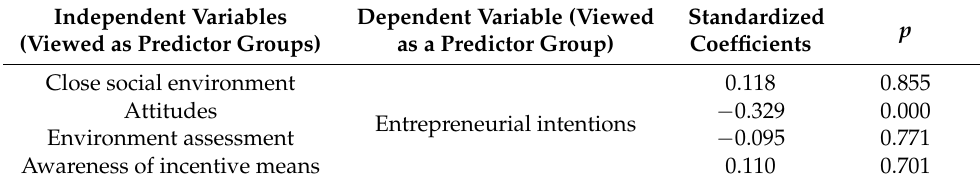
Table 5. Results of the linear regression